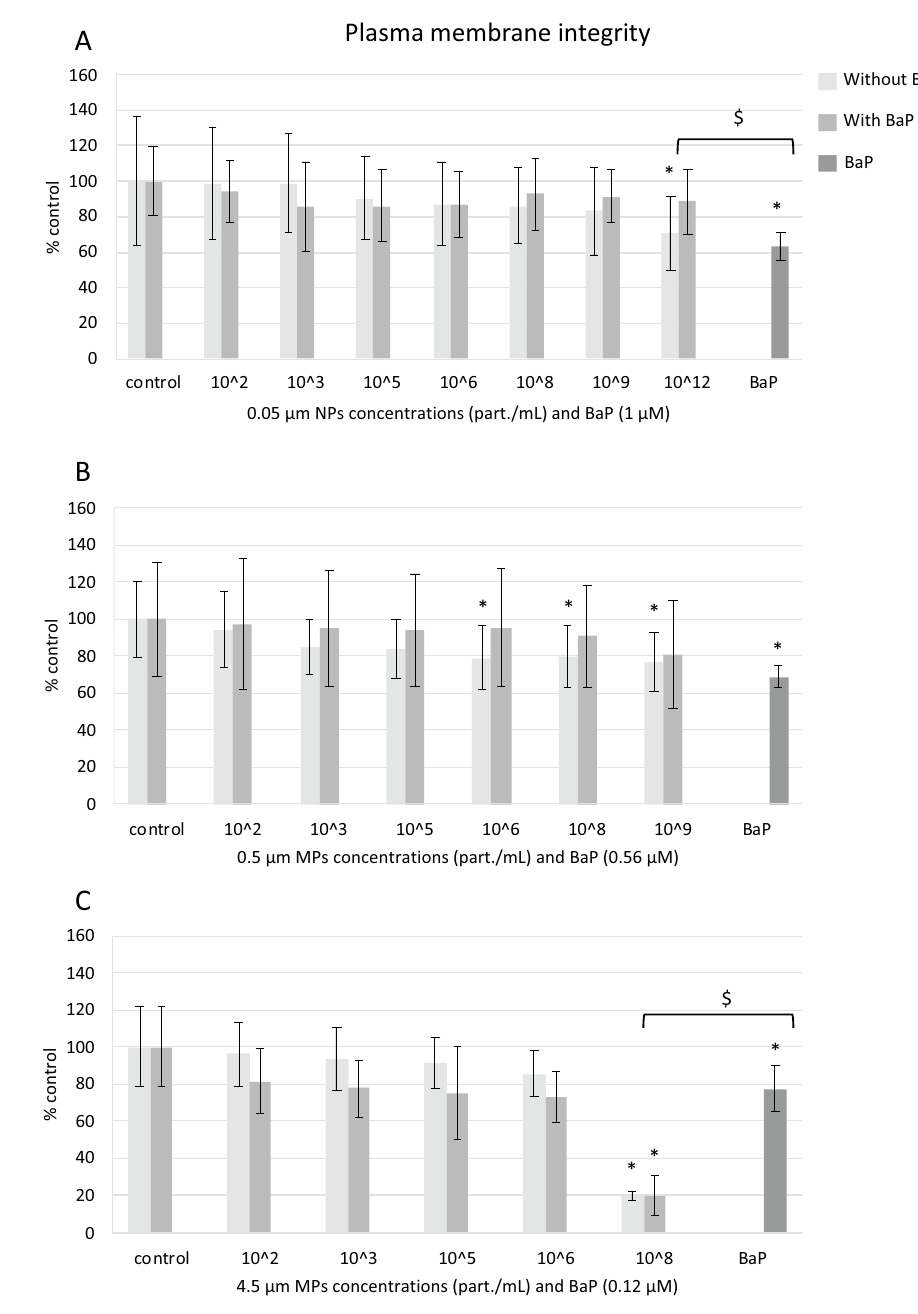
Figure 4. Plasma membrane integrity in mussel hemocytes exposed for 24 h to ( A ) 0.05 µm NPs, ( B ) 0.5 µm MPs and ( C ) 4.5 µm MPs alone or in combination with BaP and to BaP alone. Data are given as percentages with respect to control ± SD (n = 18). * indicates significant differences with respect to controls, $ indicates significant differences between NPs/MPs with BaP and BaP